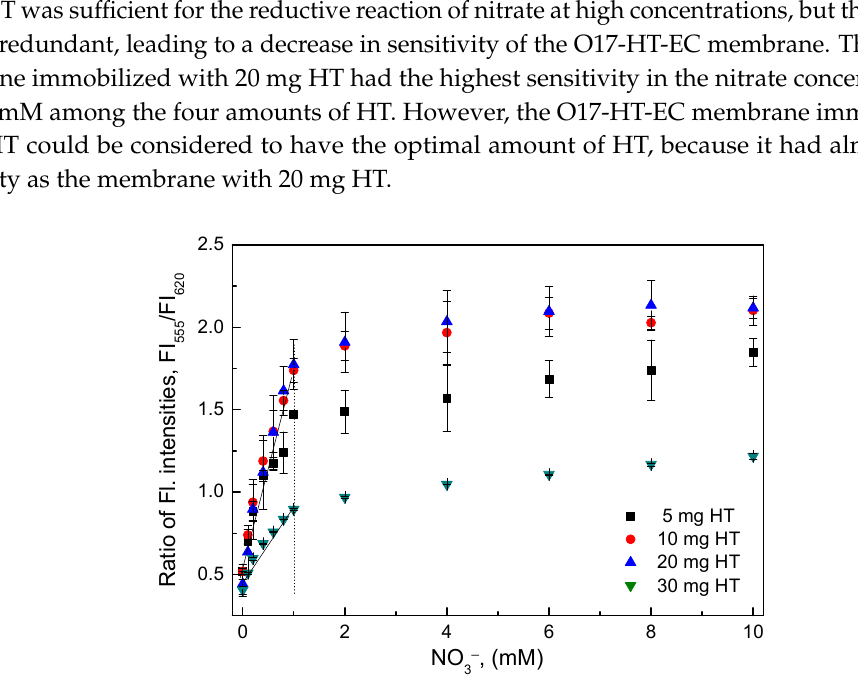
Figure 3. Response of the O17-HT-EC membranes immobilized with different amounts of hydrotalcite (HT) to various nitrate concentrations.